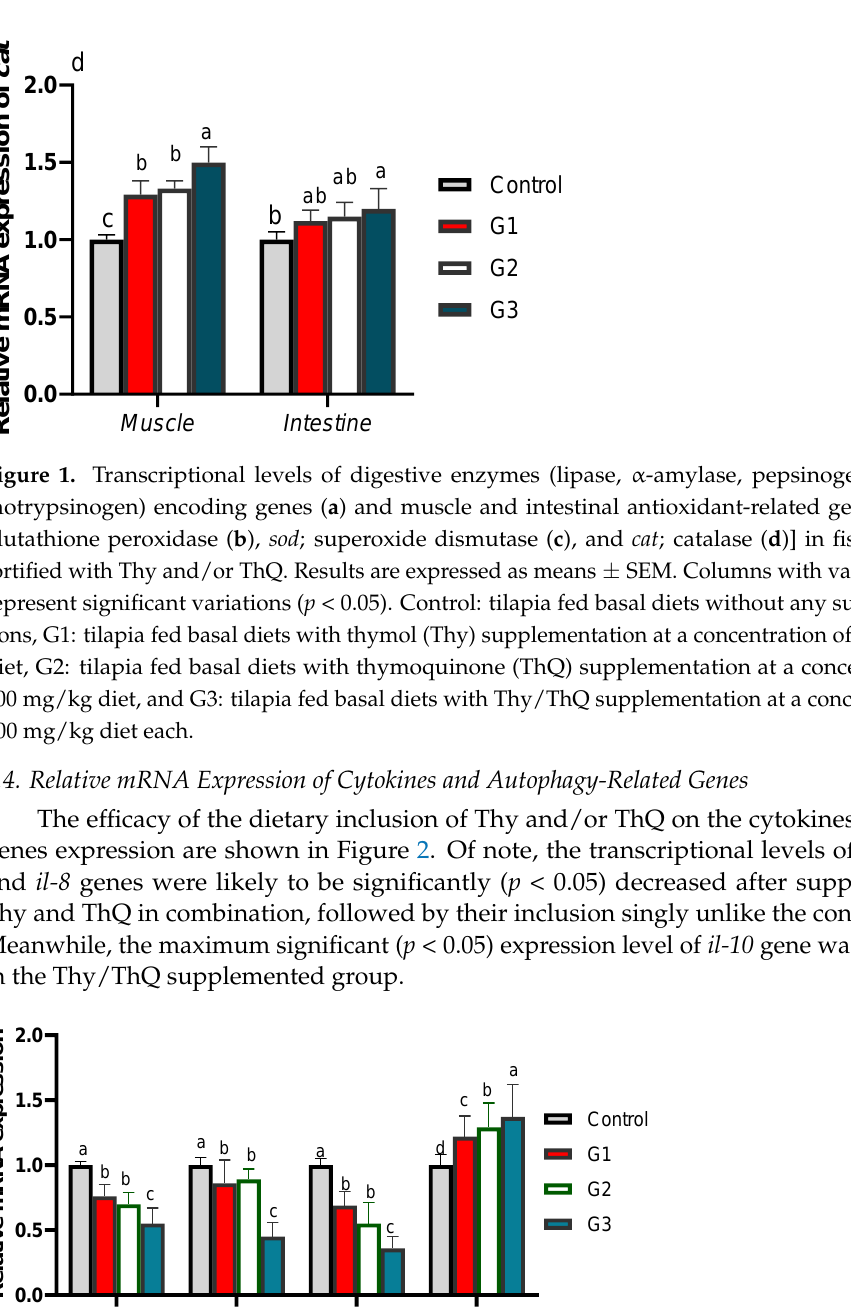
Figure 3. Analysis of quantitative reverse transcription polymerase chain reaction of autophagy ( atg5 and atg12 ), mechanistic target of rapamycin ( mtor ), beclin-1 ( bclN-1 ), and microtubule-associ- ated proteins 1A/1B light chain ( lc3-II ) encoding genes in fish fed diets fortified with Thy and/or ThQ. Results are expressed as means ± SEM. Columns with various letters represent significant var- iations ( p < 0.05). Control: tilapia fed basal diets without any supplementations, G1: tilapia fed basal diets with thymol (Thy) supplementation at a concentration of 200 mg/kg diet, G2: tilapia fed basal diets with thymoquinone (ThQ) supplementation at a concentration of 200 mg/kg diet and G3: ti- lapia fed basal diets with Thy/ThQ supplementation at a concentration of 200 mg/kg diet each.